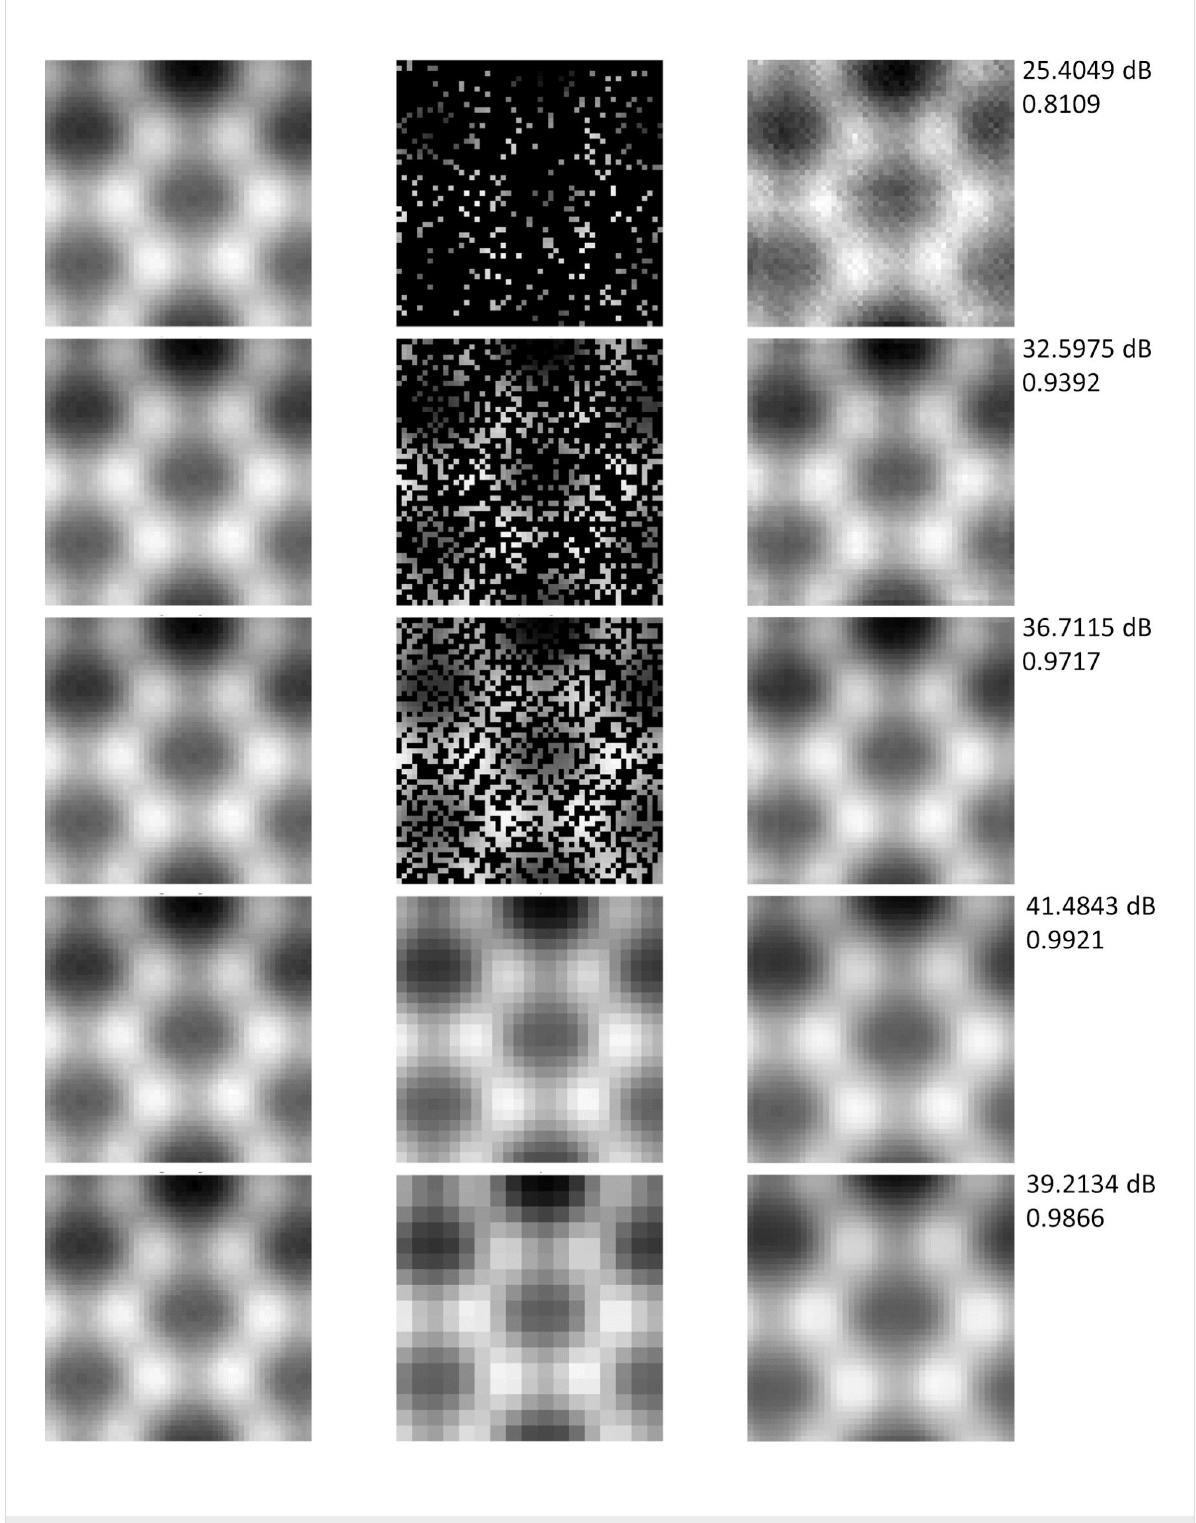
Figure 6: The reconstructed results of Figure 5a with size of 51 × 51. The first column is the original image, the second column is the undersampling image (or low-resolution image), and the last column is the reconstructed image. PSNR and SSIM are indicated on the right side of each image. The first three lines are the BCS results with under-sampling rates of 0.11, 0.3, and 0.5, respectively. The last two lines are the SRCNN results with scale factors of 2× and 3×,